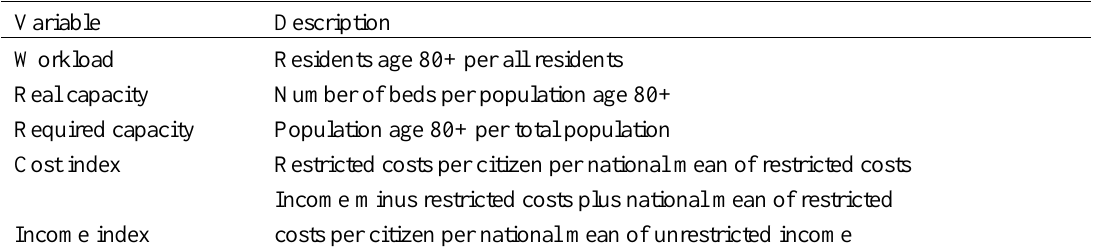
Table A2: Municipality